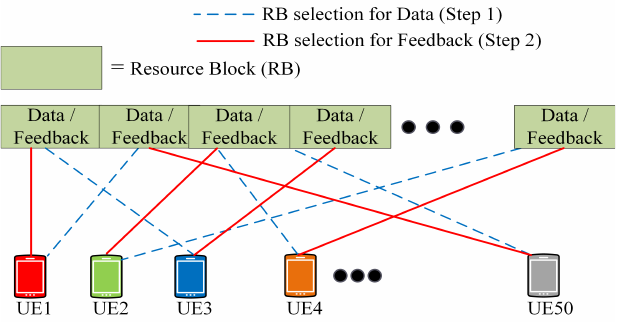
Figure 5. Resource selection in ARS, Mode